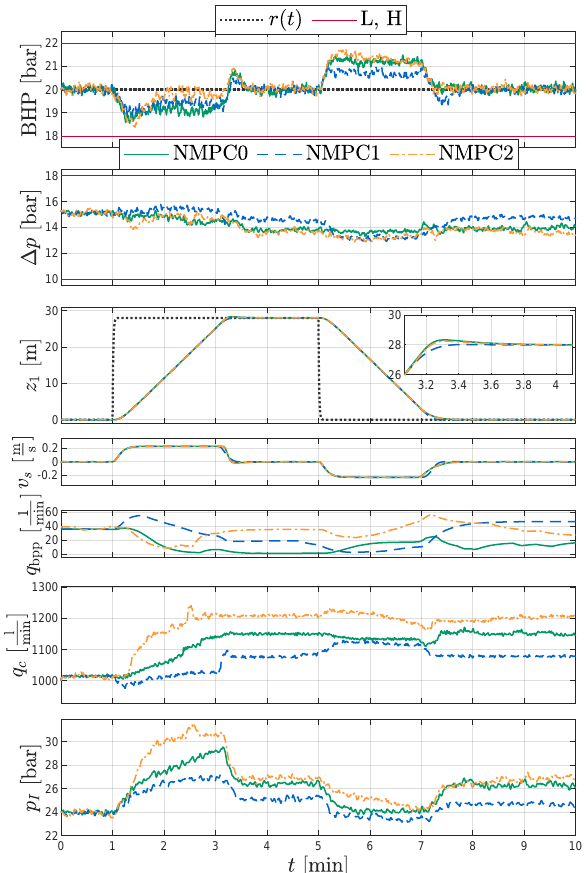
Figure 8: Tracking constant BHP and reference tajec- tory for travelling block.